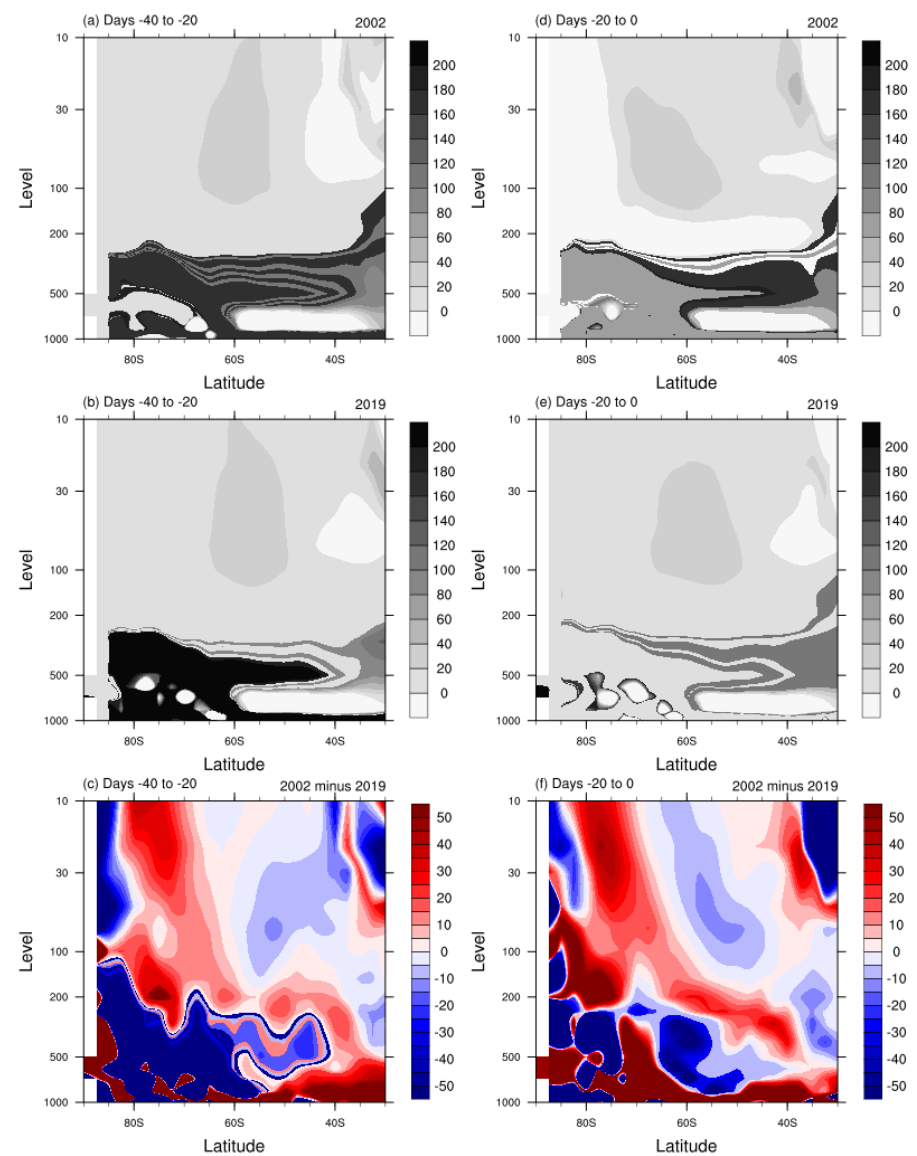
Figure 9. The height-latitude cross sections of the W1 refractive index for (top row) the 2002 Antarctic SSW, (middle row) the 2019 Antarctic SSW, and (bottom) the difference between two events. ( a – c ) The refractive index averaged − 40 to − 20 days before the onset of warming. ( d – f ) The index averaged − 20 to 0 days before the onset. The onset dates of the warming in 2002 and 2019 are taken as 20 September and 5 September, respectively. The refractive index is multiplied by Earth’s radius squared, which nondimensionalizes the refractive index.